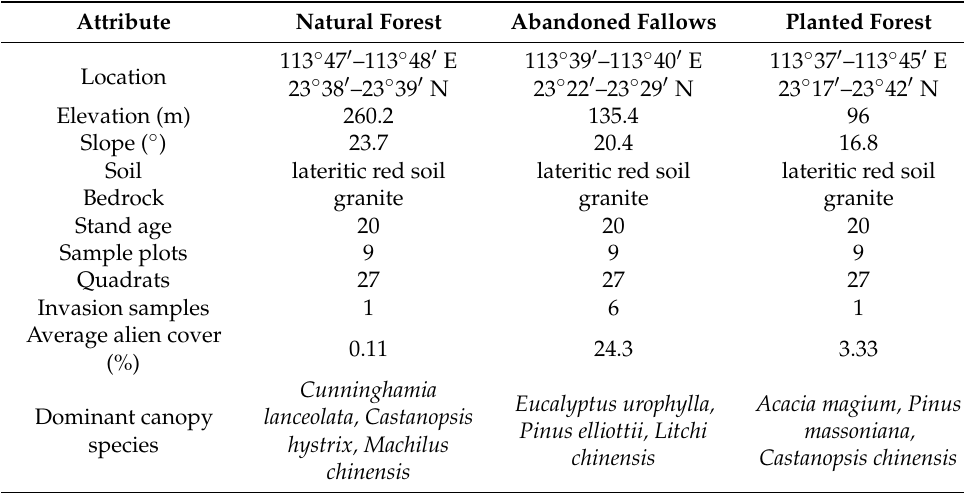
Table 2. Classification of the range of height and cover classes.